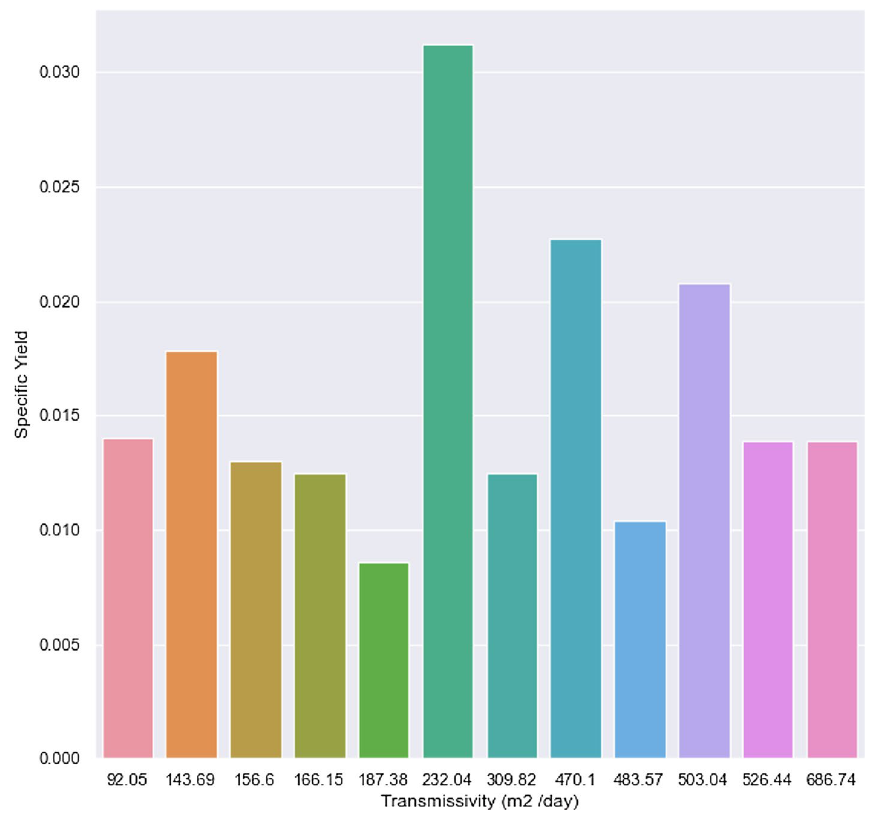
Fig. 4 Transmissivity versus specific yield of wells